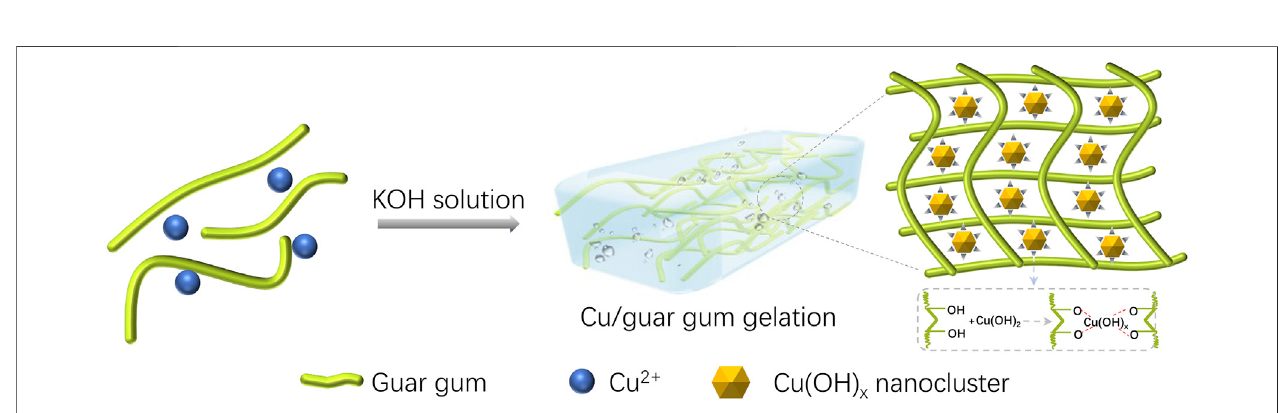
Frontiers in Chemistry |